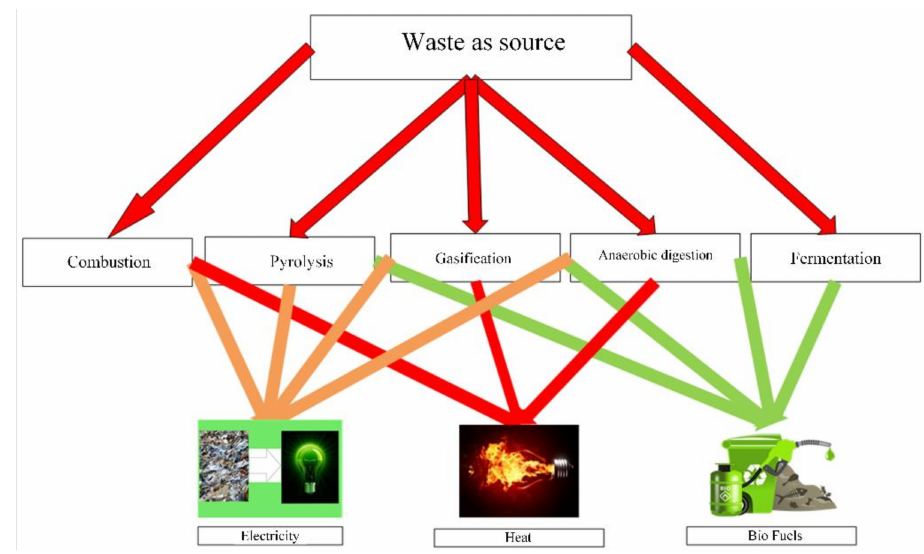
Figure 5. Different processes of waste-to-energy.